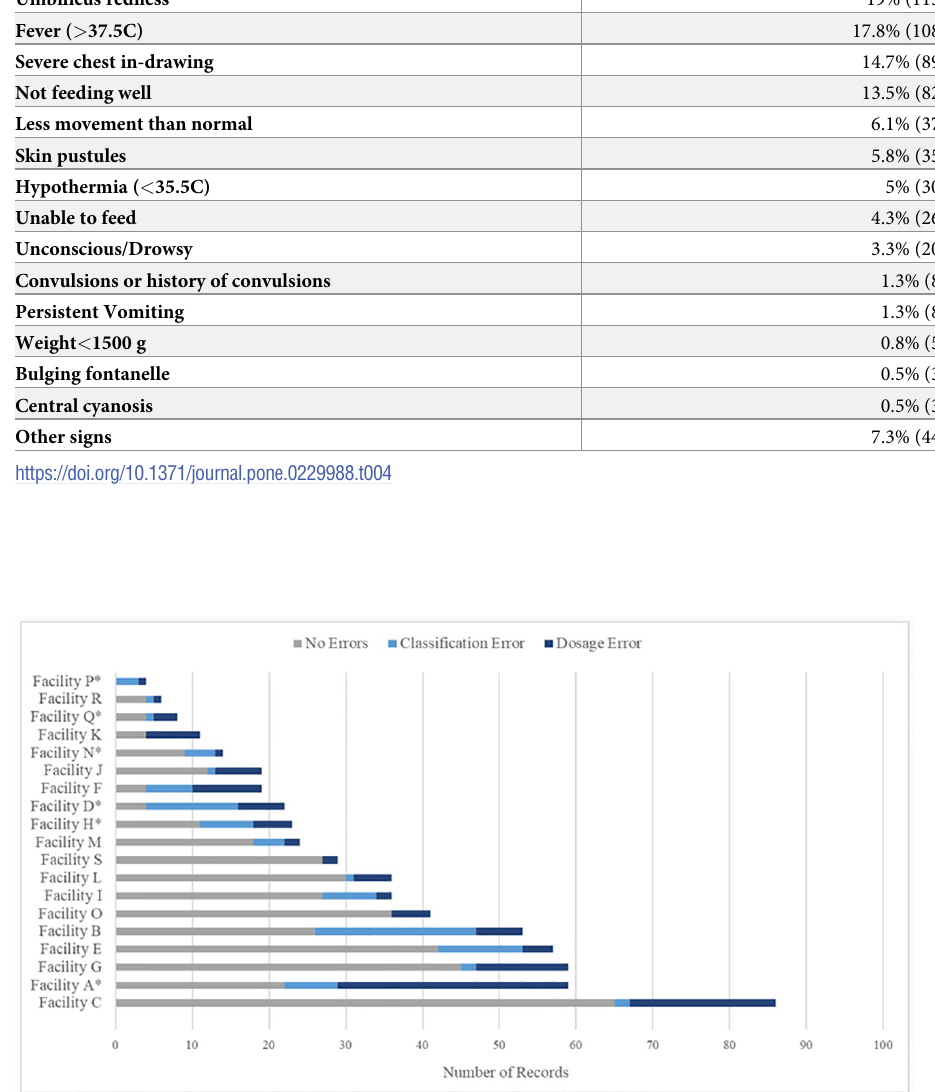
Fig 2. Distribution of young infant records and errors by health center. Facilities A, B and C contribute 39.3% of total errors; � Denotes a facility that contributed records (N = 9) containing both errors in classification and dosage.